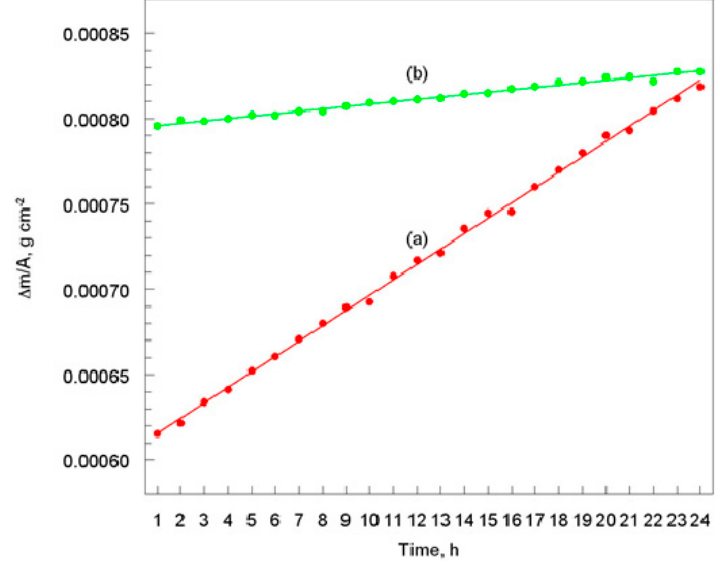
Figure 5. Influence of exposure time on mass change, during heat treatment in air atmosphere: ( a ) S355 steel and ( b ) S355 steel with DLC coating. Exposure temperature of 400 °C.